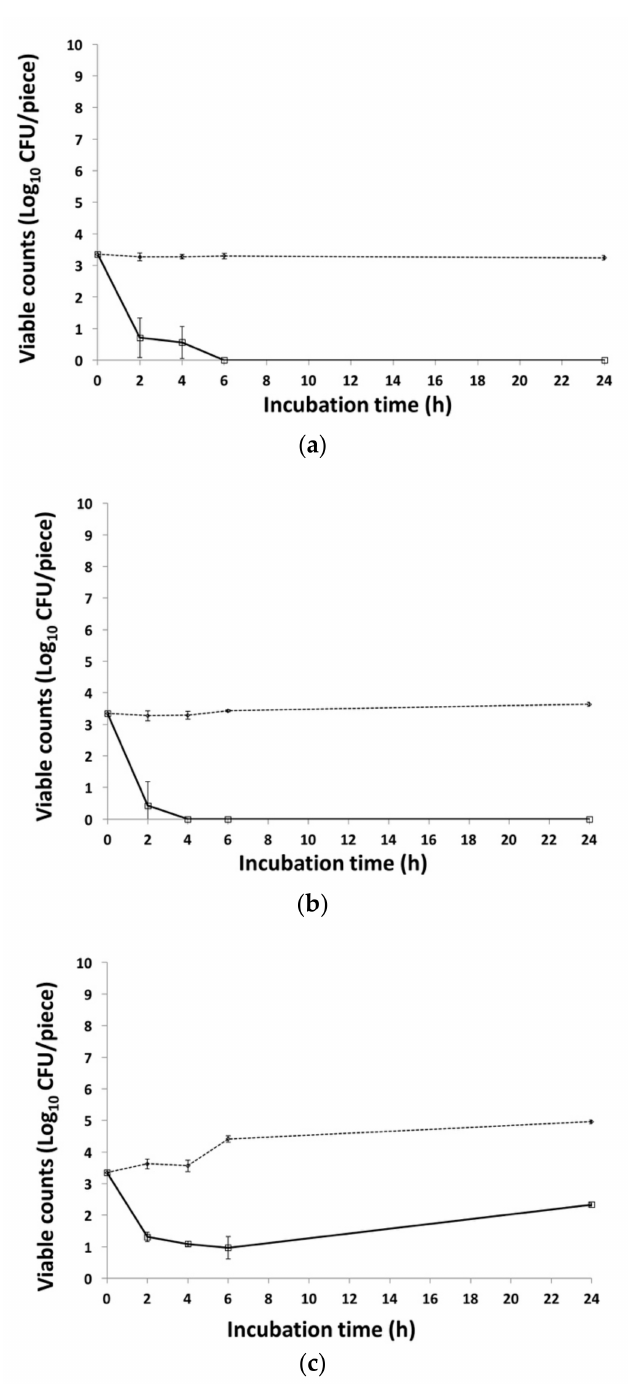
Figure 3. Effect of phage VR26 on numbers of STEC O26:H11 on fresh lettuce at 4 ( a ), 8 ( b ), and 22 ◦ C ( c ). Solid line, VR26-treated lettuce pieces; dashed line, control. Bars present standard deviation. At 22 ◦ C, the pathogen was reduced by more than 2 log 10 CFU within 6 h and, although bacterial regrowth was observed afterward, O26:H11 counts on non-treated lettuce pieces were >2 log 10 CFU/piece higher than on phage-treated samples (2.3 ± 0.06 log 10 CFU/piece) ( p <